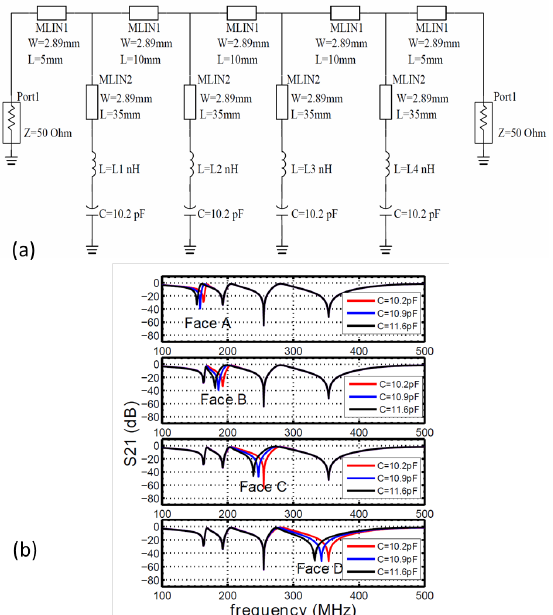
Figure 3. ( a ) The schematic of the circuit simulation. C 1 = 10.2 pF; L i ( i = 1,2,3,4) is 82 nH, 56 nH, 27 nH and 8.2 nH, respectively. ( b ) Transmission spectrum given by circuit simulations. The four sub-figures indicate the change in capacitance at four sensing elements, A, B, C, D, with different inductance values. In each sub-figure, curves with different colors represent different capacitance values.